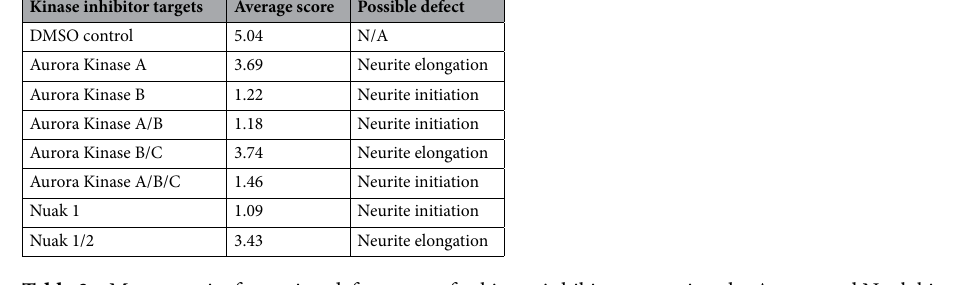
Table 3. Mean neurite formation defect scores for kinase inhibitors targeting the Aurora and Nuak kinases reveal possible defects in neurite initiation and/or elongation.